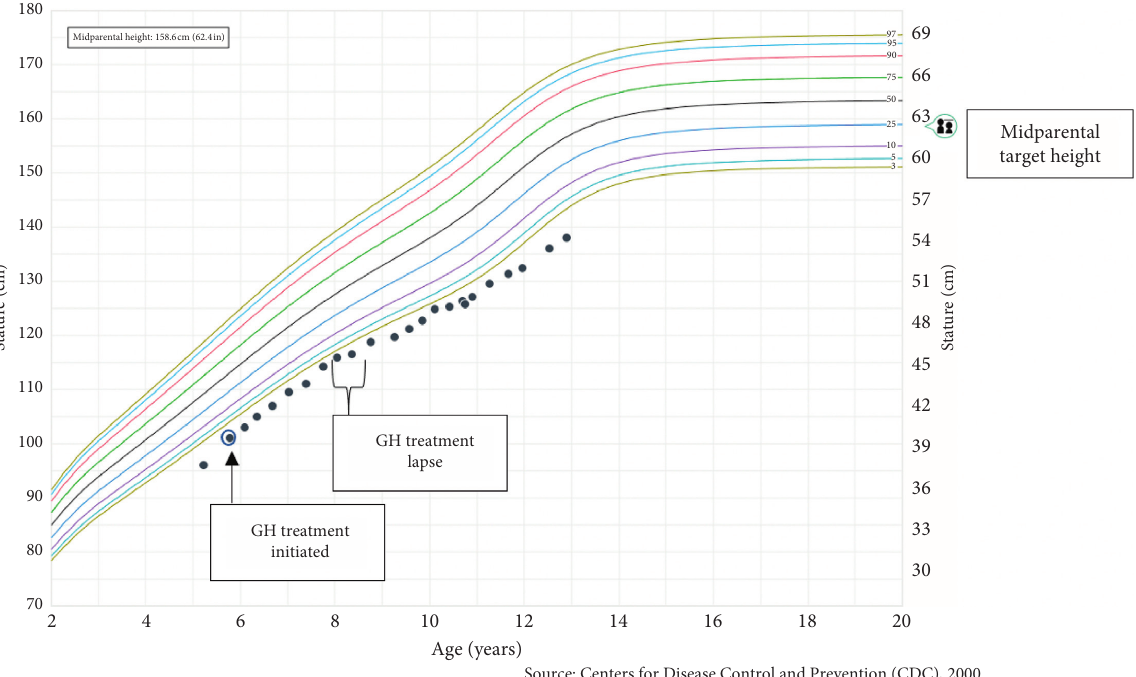
Figure 2: Plotted stature-for-age percentiles for Jane Doe. Centers for Disease Control and Prevention (CDC) stature-for-age percentiles, girls 2 to 20 years